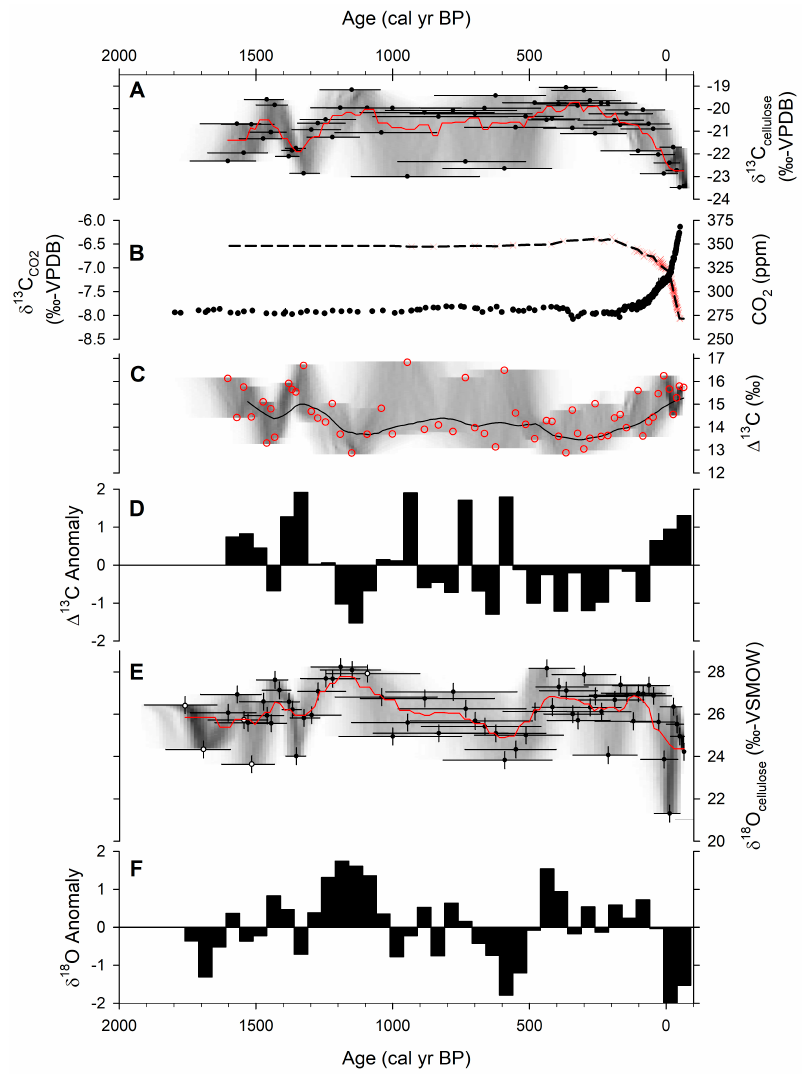
Figure 3. Stable isotope results for peatbank core LIT-4 from Litchfield Island: ( A ) δ 13 C cellulose from C. aciphyllum with age uncertainty (shading); ( B ) ice-core measurements of atmospheric δ 13 C CO2 (red), smoothed curve (black dashed line), and CO 2 concentration (black) [45]; ( C ) Δ 13 C for C. aciphyllum moss from core LIT-4 (see equation (1)) with age uncertainty (shading); ( D ) resampled 50-year intervals and calculated anomaly of Δ 13 C; ( E ) δ 18 O cellulose from C. aciphyllum (samples smaller than the smallest reference noted in white) with age uncertainty (shading); ( F ) resampled 50-year intervals and calculated anomaly of δ 18 O cellulose .